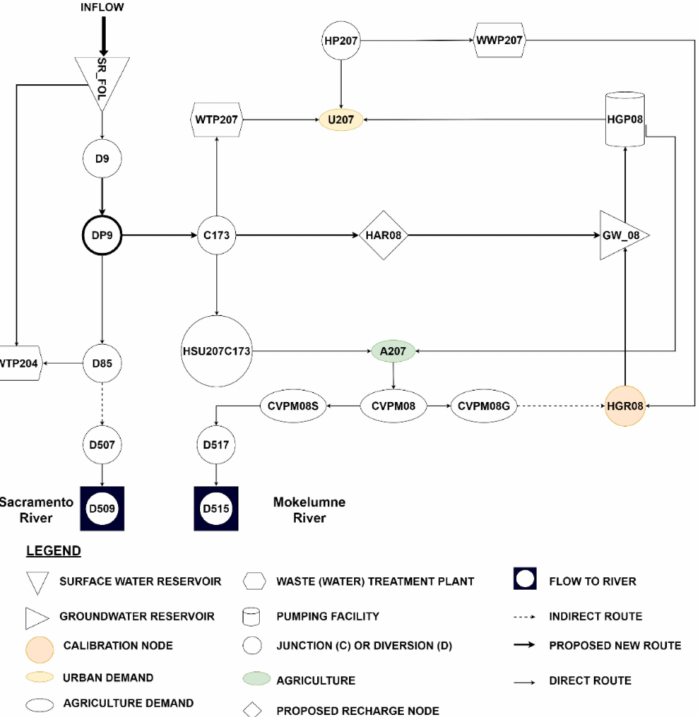
Figure 2. The California Water Network portion in the Lower American River Basin, south of Folsom